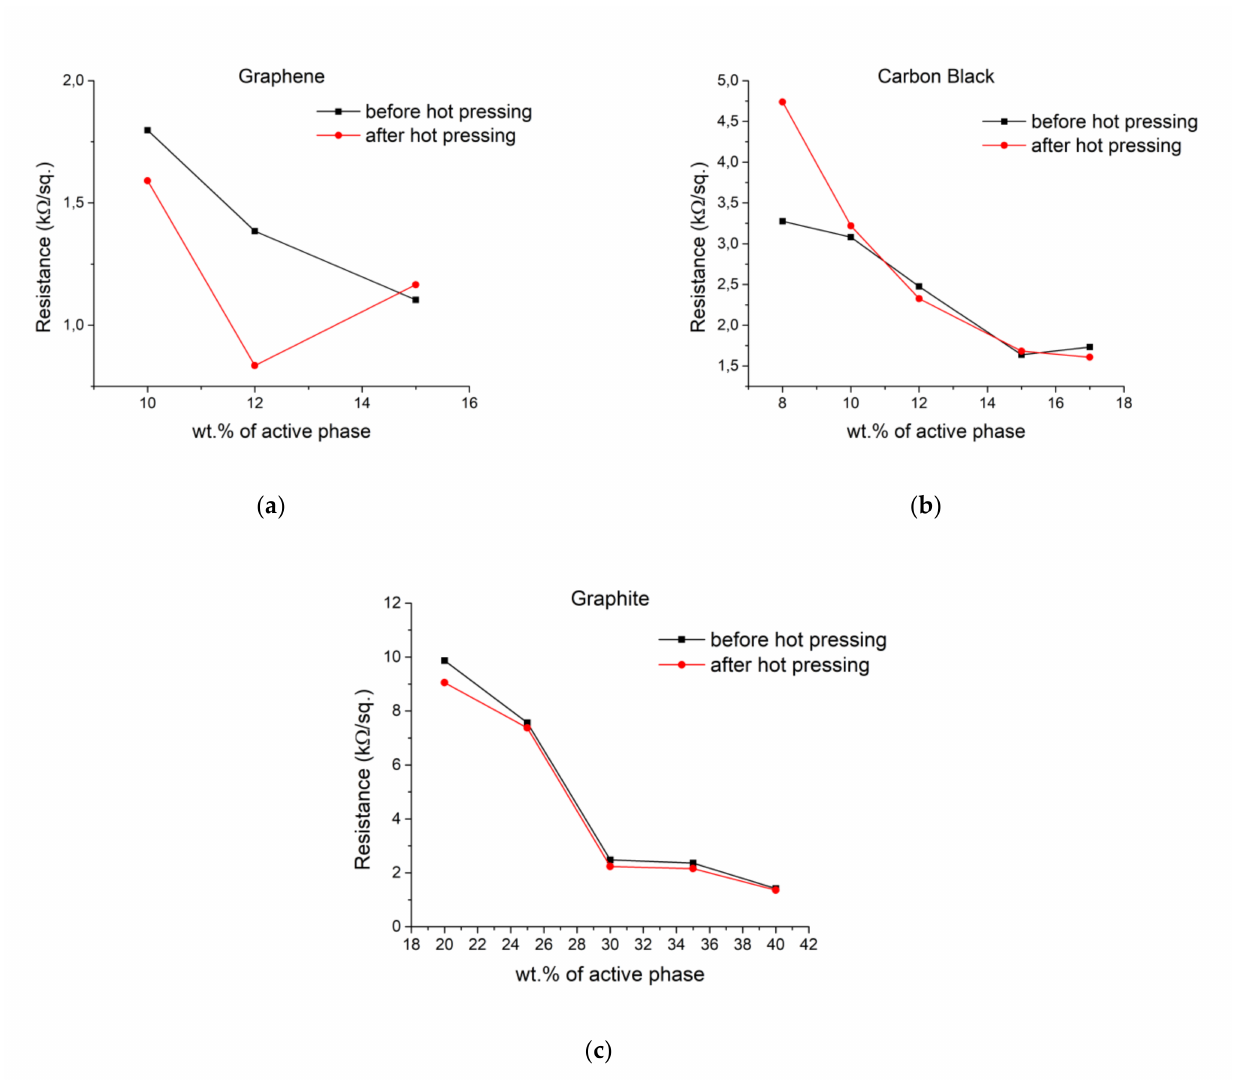
Figure 3. Comparison of resistances before and after a hot pressing process for heaters screen-printed with different compositions of pastes based on: ( a ) Graphene; ( b ) Carbon black; ( c )